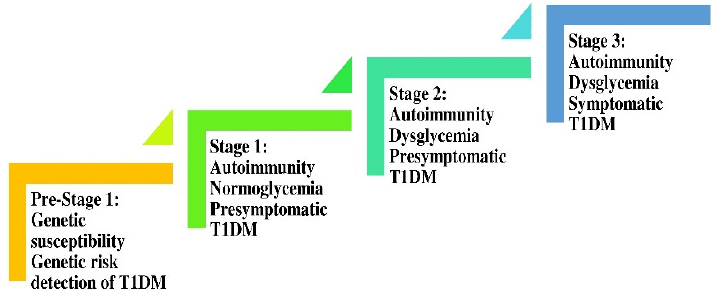
Figure 2. The staging of T1DM according to genetic susceptibility and autoimmunity. Abbreviations: T1DM, type 1 diabetes mellitus.